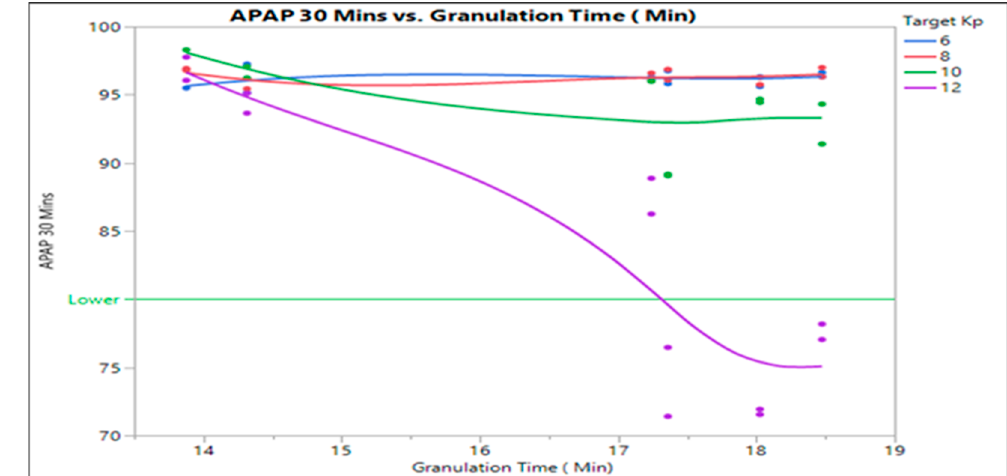
Figure 18. % Acetaminophen (APAP) tablet disintegration target of 30 min (on the y-axis) vs. Granulation time (in minutes) on the x-axis. Granulation transforms the shape, size, surface, and density of powders to improve their physicochemical properties and hardness. The higher the granulation time (and KP), the more negative the effect on tablet disintegration. For example, if increased to 12 KP, 50% of the sample failed in dissolution batch testing.